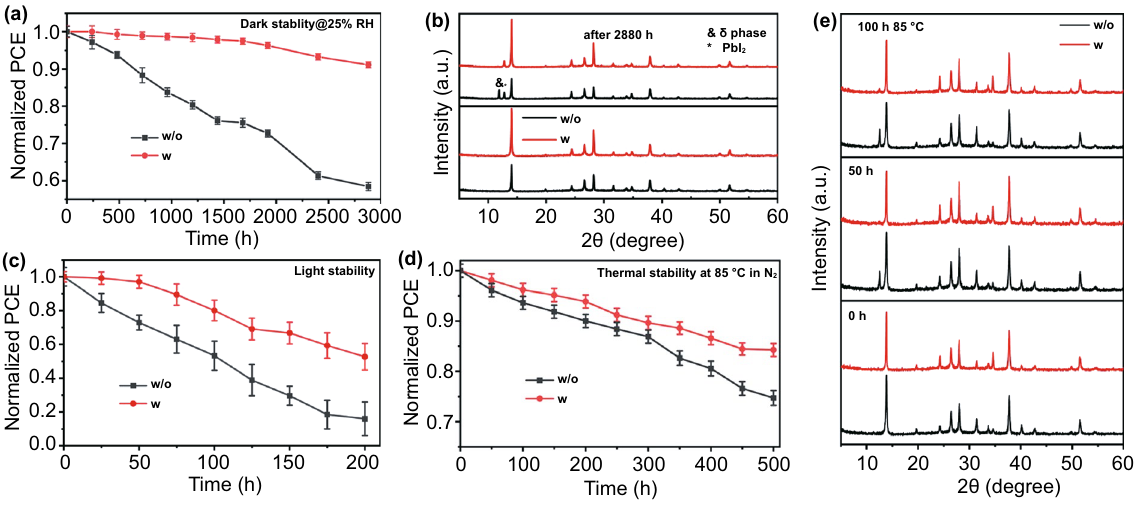
Fig. 7 a Air stability (humidity: ≈25%). b XRD pattern of the hybrid PSCs with and without BBF additive after aging in air for 2880 h. c Light stability and d thermal stability (T: ≈85 °C in N 2 atmosphere) of the PSCs with and without BBF additive. e XRD patterns of the perovskite films with and without BBF additive after aging at 85 °C in N 2 atmosphere for 50 h and 100